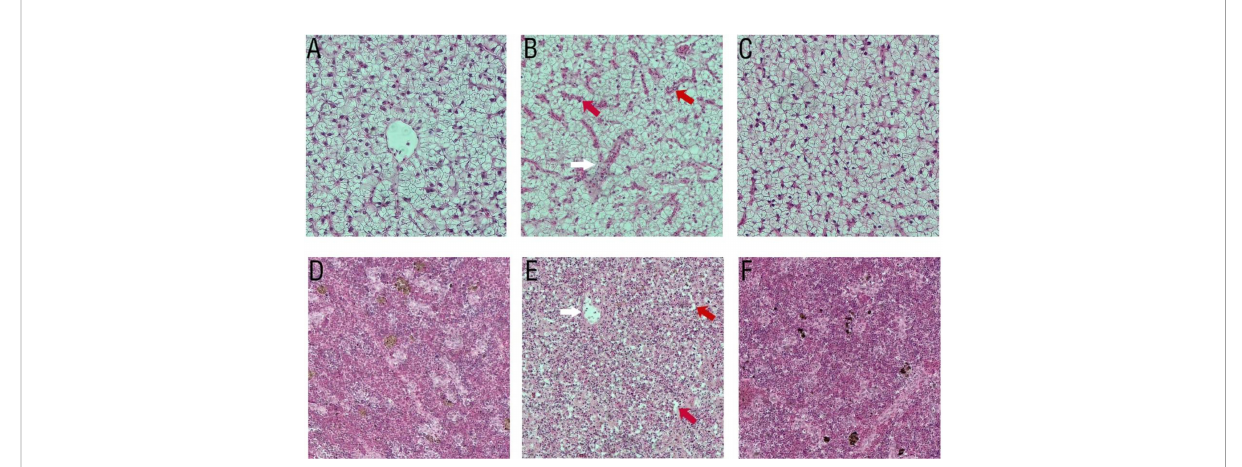
FIGURE 9 Histopathological changes in liver (100 × magni fi cation) and spleen (100 × magni fi cation) of pearl gentian grouper after infection with V. alginolyticus . (A, D) PBS group, (B, E) PBS group infected with V. alginolyticus HY9901, (C, F) D dctP group infected with V. alginolyticus HY9901. (A, C) Liver of group and D dctP group show normal hepatocytes structure and organization. (B) Liver of V. alginolyticus HY9901 group show pronounced liver sinus congestion (red arrow) and hemorrhage (white arrow). (D, F) Spleen of PBS group and D dctP group show normal hepatocytes structure and organization. (E) Spleen of V. alginolyticus HY9901 group shows splenic cord-unclear (red arrow) and necrotic foci (white